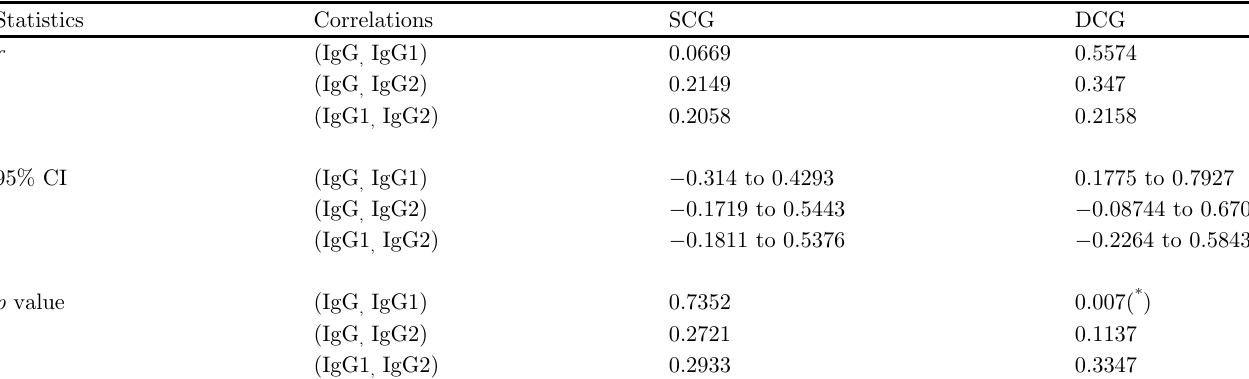
Table 1. Analyses of correlations between IgG, IgG1, and IgG2 as a function of the variable of clinical state.